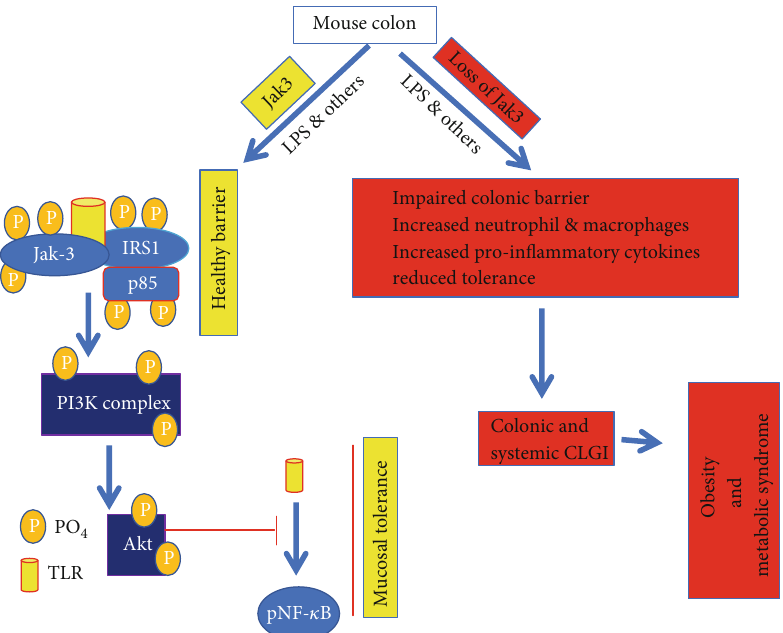
Figure 5: Proposed models for Jak3-mediated mucosal tolerance and predisposition to obesity and MetS di ff erentiated and polarized state of mucosal epithelial tissue architecture. AJ is created by the interactions between among others, sticky homotypic transmembrane protein cadherin.